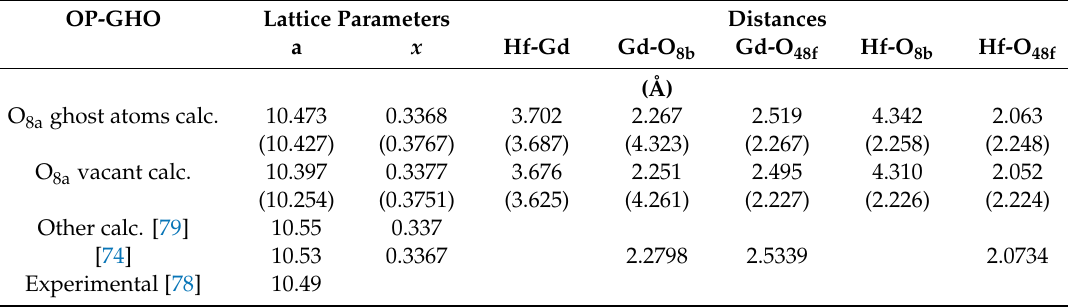
Table 1. Lattice parameters (a and x) and the nearest metal-metal and metal-O interatomic distances for the DFT-optimized OP-GHO structures. Values in parentheses refer to the cation antisites. OP-GHO Lattice Parameters Distances a x Hf-Gd O 8a ghost atoms calc.